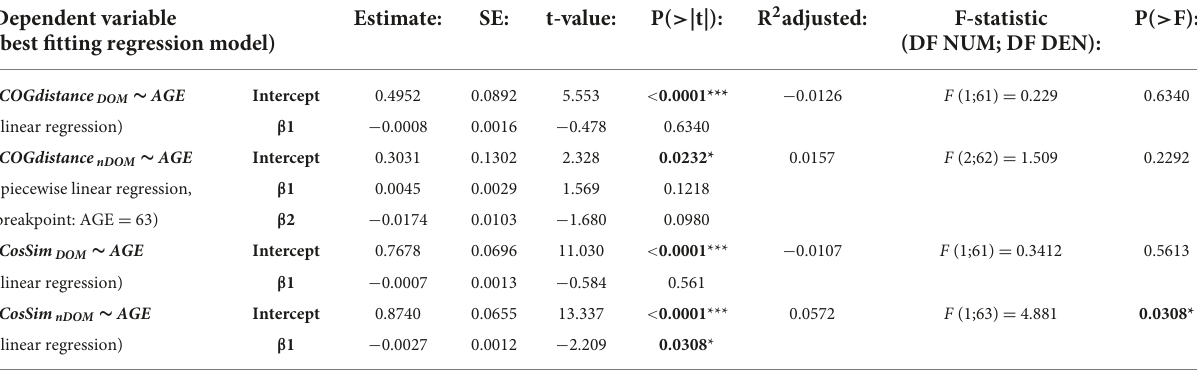
TABLE 5 Point estimates, standard error (SE) and statistics for regression models for similarity of first dorsal interosseus (FDI) and abductor digiti minimi (ADM) with AGE as independent variable. Dependent variable (best fitting regression